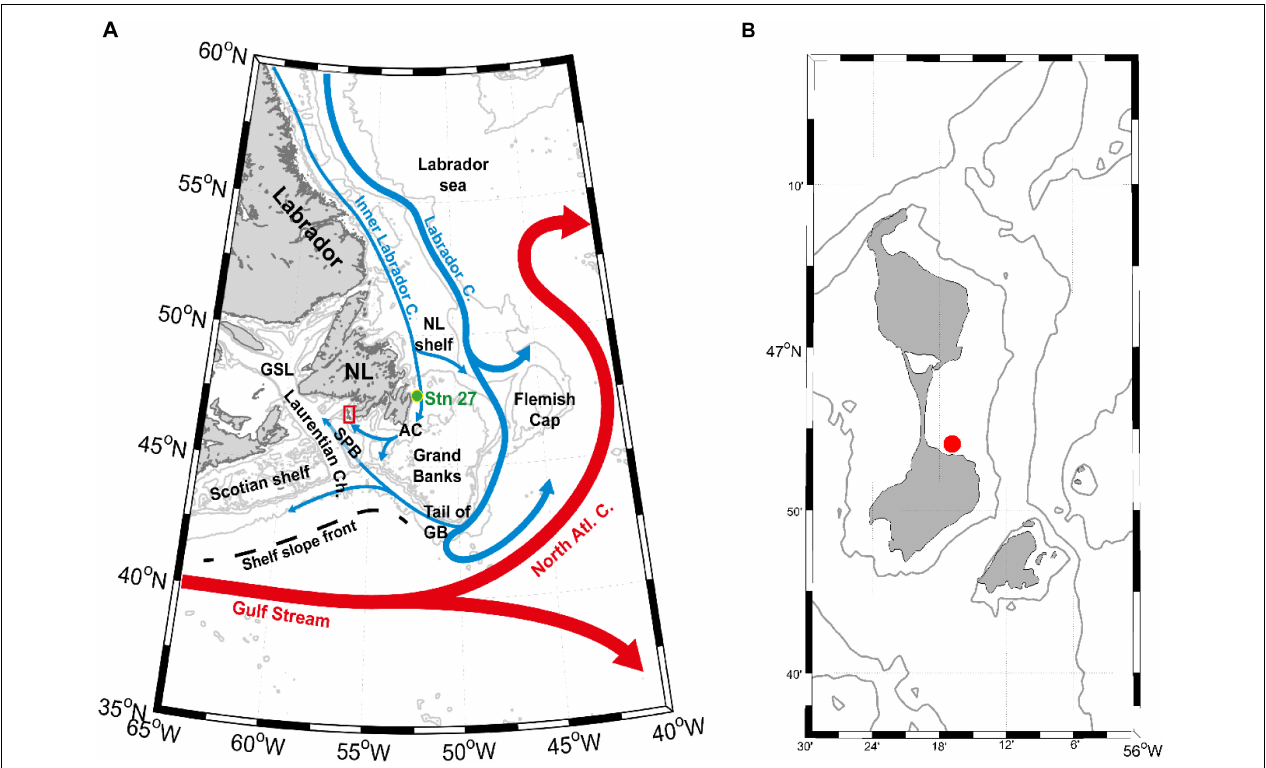
FIGURE 1 | (A) Major features of the regional surface circulation (inspired in the figure Fratantoni and McCartney, 2009) and main location names. The cold inner and outer LCs are in blue; Gulf Stream and North Atlantic currents are in red; black dashed line represents the Shelf Slope Front mean position (according to Peterson et al., 2017). In green is historical hydrographic Station 27 (Stn. 27). The main acronyms corresponding to location names are as follows: NL – Newfoundland; SPB – Saint-Pierre Bank; GSL – Gulf of Saint-Lawrence; AC – Avalon Channel; and GB – Grand Banks. (B) Sampling location of Arctica islandica (red